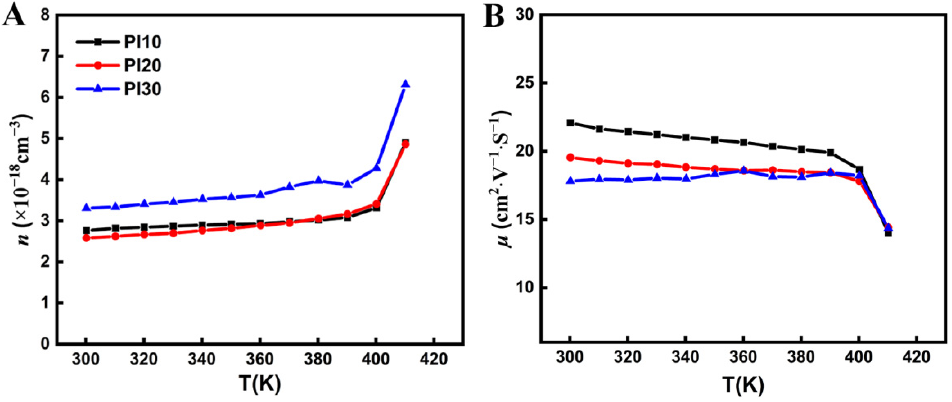
Figure 4. Temperature dependence for ( A ) carrier concentration; ( B ) mobility of PI10, PI20, and